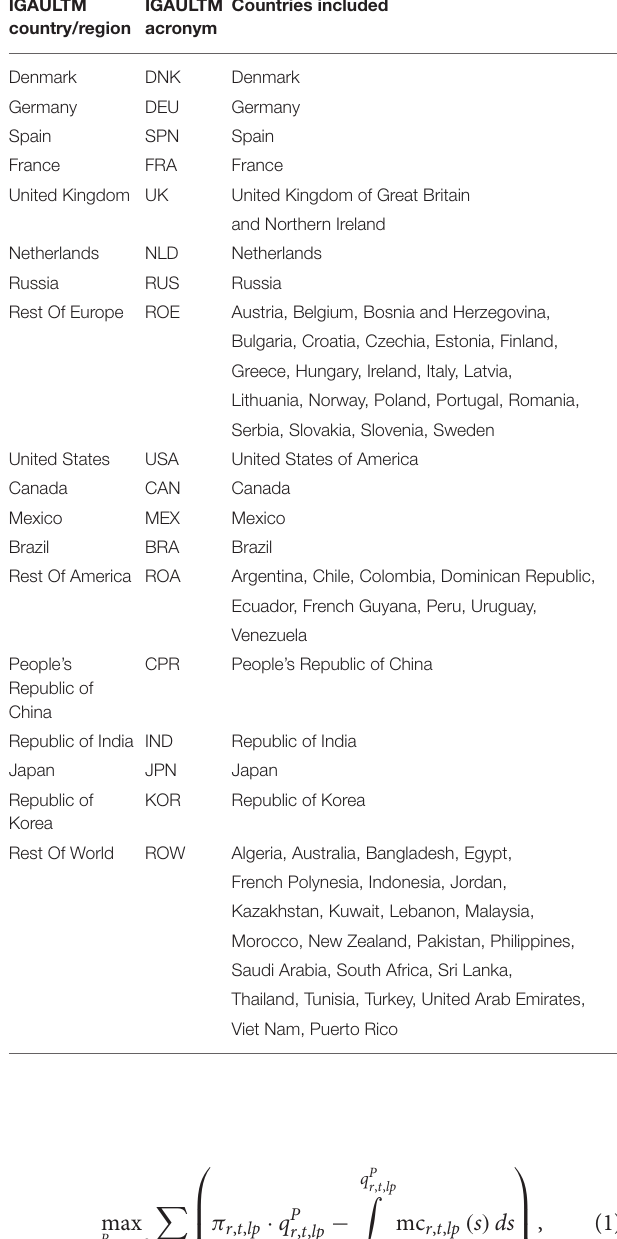
TABLE 1 | Regional disaggregation in